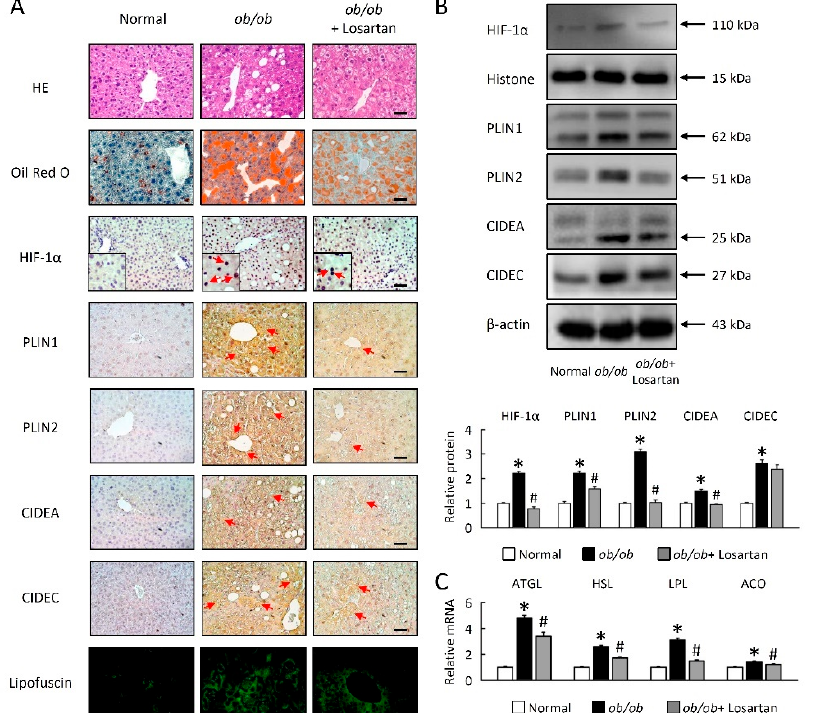
Figure 2. Losartan decreased HIF-1 α and LD-associated proteins. ( A ) Representative HE, Oil Red O, HIF-1 α , PLIN1, PLIN2, CIDEA and CIDEC staining of liver from normal mice and losartan-treated ob / ob mice. Green pseudo-color represents visualization of lipofuscin’s autofluorescence at 450–490 nm. Red arrow highlights the positive staining. Scale bar: 100 µ m. Quantification of ( B ) HIF-1 α , PLIN1, PLIN2, CIDEA, and CIDEC protein levels by Western blot of liver after losartan treatment. Below graphs indicate quantification relative to Histone or β -actin. ( C ) Quantification of ATGL, HSL, LPL, and ACO by qRT-PCR. qRT-PCR indicates quantification relative to GAPDH. For each animal group, n = 5. All values represent the mean ± SEM. Data were analyzed by Student’s t test. * p ≤ 0.05; normal vs. ob/ob . # p ≤ 0.05; ob/ob vs. ob/ob + Losartan. HIF-1 α , hypoxia-inducible factor-